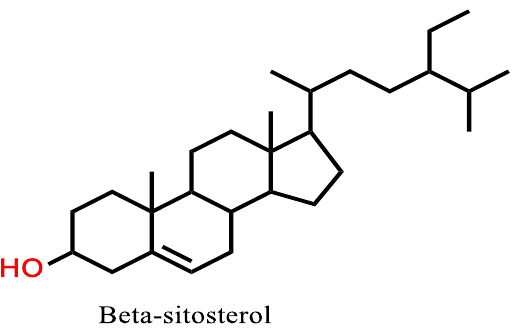
Figure 14. The molecular structure of beta-sitosterol has been attributed mainly to the Aro-3 fraction (~90%) due to the presence of the hydroxyl group. Stereochemistry is omitted for clarity. (The red color indicates OH group.)